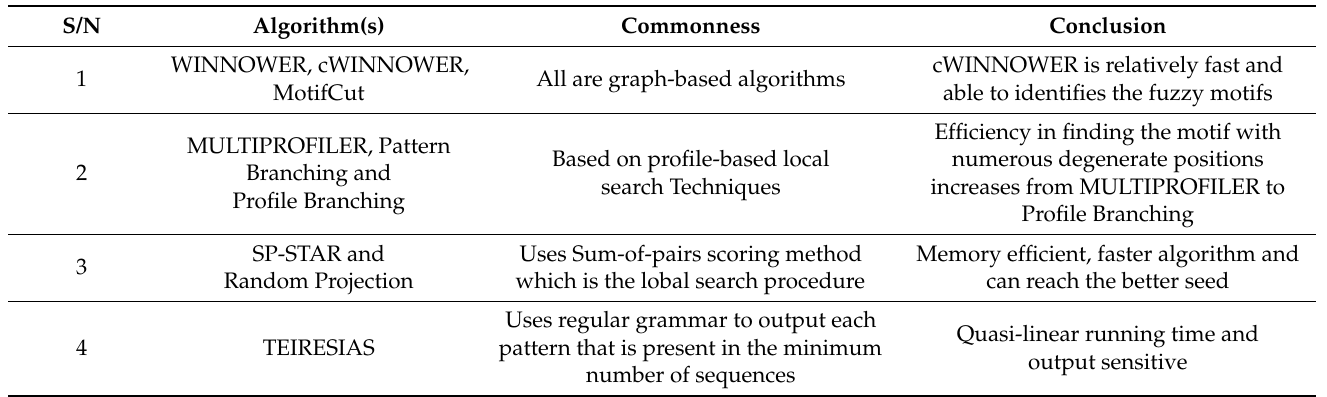
Table 2. Summary of Motif Discovery Algorithms based on Local Search